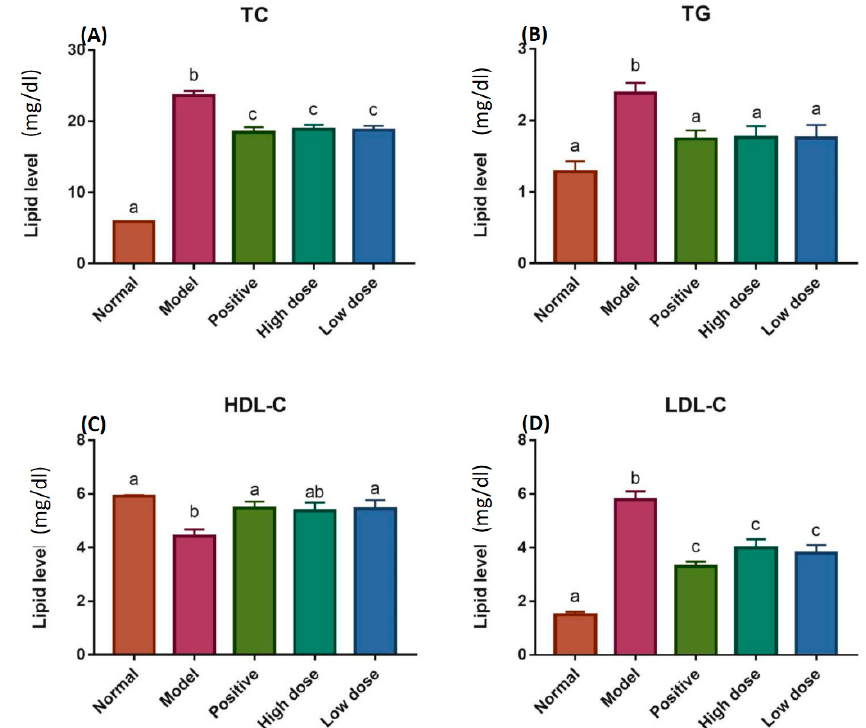
Figure 3. The lipid levels of TC, TG, HDL-C and LDL-C in the serum of ApoE-knockout (KO) mice. ( A ) Total cholesterol (TC), ( B ) Triglyceride (TG), ( C ) High-density lipoprotein cholesterol (HDL-C), and ( D ) Low-density lipoprotein cholesterol (LDL-C) levels in the serum were measured after feeding with high-fat diet for 8 weeks. Different labels above columns in ( A – D ) indicate a significant difference tested by One-way ANOVA between different experimental groups with p < 0.01.